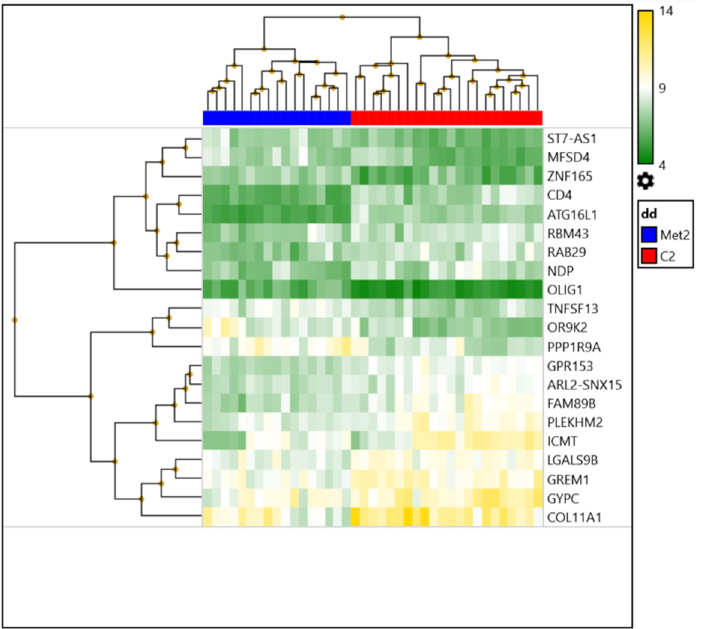
Figure 3. Heat map of DEG in tumors of patients with breast cancer after neoadjuvant chemotherapy, depending on the status of hematogenous metastasis. Table 3. Upregulated and downregulated DEG in tumors of patients with breast cancer after neoadjuvant chemotherapy, depending on the absence/presence of hematogenous metastasis. Exp. Levels Upregulated DEGs